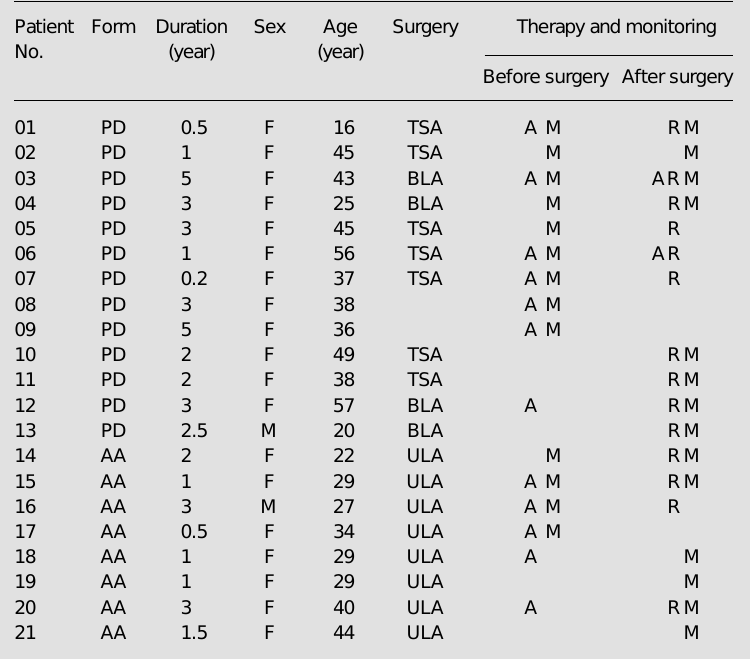
Table 1 - Data for 21 patients with Cushing’s syndrome (PD = pituitary dependent, AA = adrenal adenoma) with 27 BP monitoring runs before and/or after surgery (TSA = transsphenoidal adenotomy, BLA = bilateral adrenalectomy, ULA = unilateral adrena-